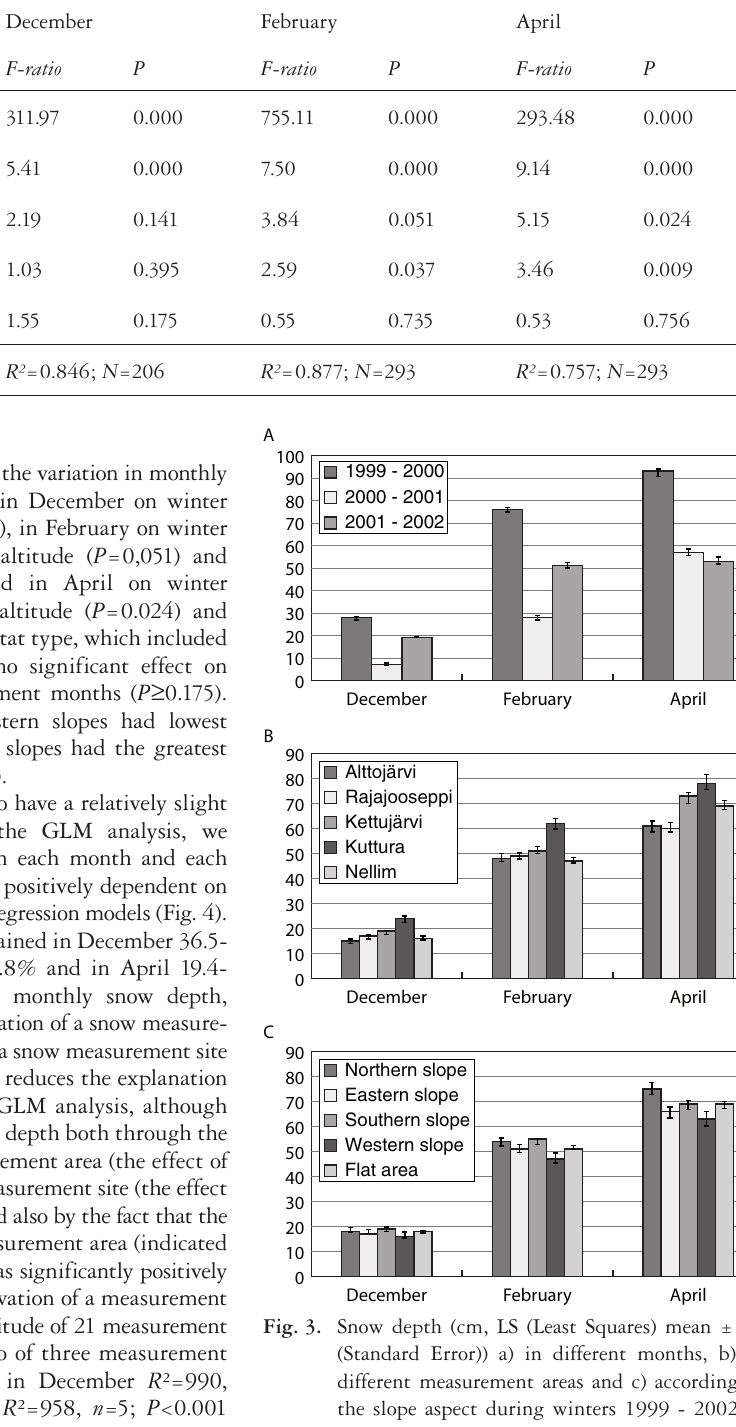
Table 1. Effect of different variables on snow depth (cm) in the Ivalo reindeer herding district during three successive winters (1999 - 2002). Multivariate GLM.